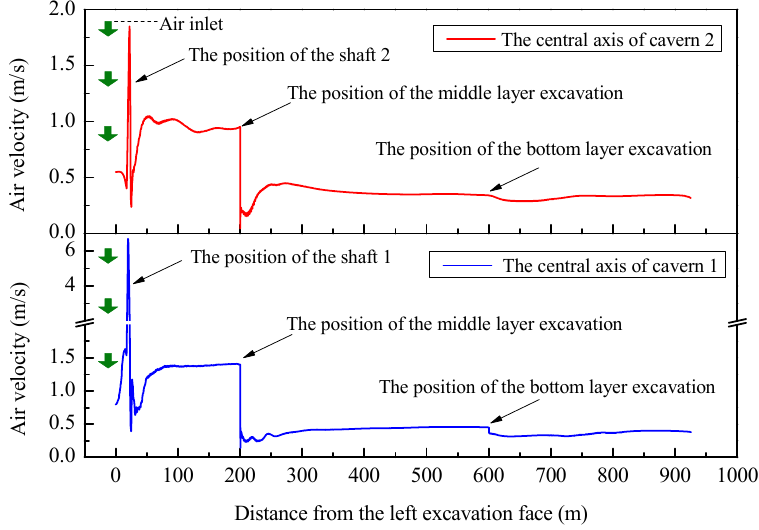
Figure 12. Air velocity distribution in the central axis of the caverns.